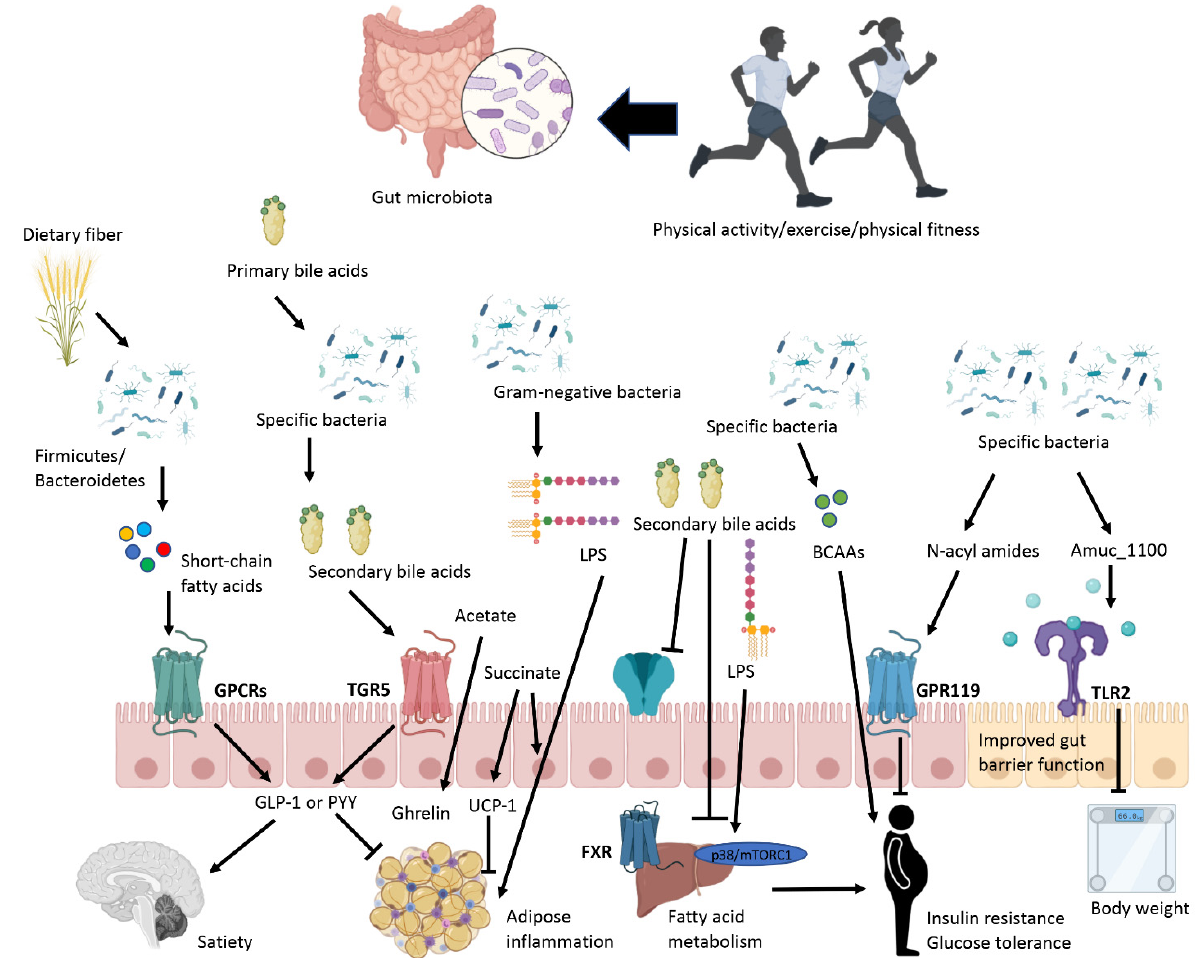
Figure 1. Impact of exercise on gut microbiota in obesity. Abbreviations: BCAA, branched-chain amino acids; FXR, farnesoid X receptor; LPS, lipopolysaccharide; GLP-1, Glucagon-like peptide 1; GPCRs, G-protein-coupled receptors; GPR119, G protein-coupled receptor 119; PYY, Peptide YY; UCP-1, Uncoupling protein 1; TGR5, G-protein-coupled bile acid receptor, TLR2, toll-like receptor 2.